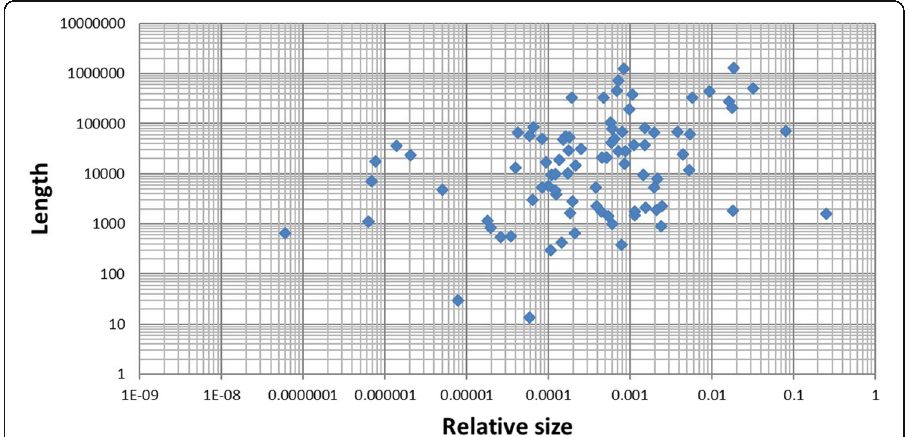
Fig. 3 Length versus relative size for 2010 –